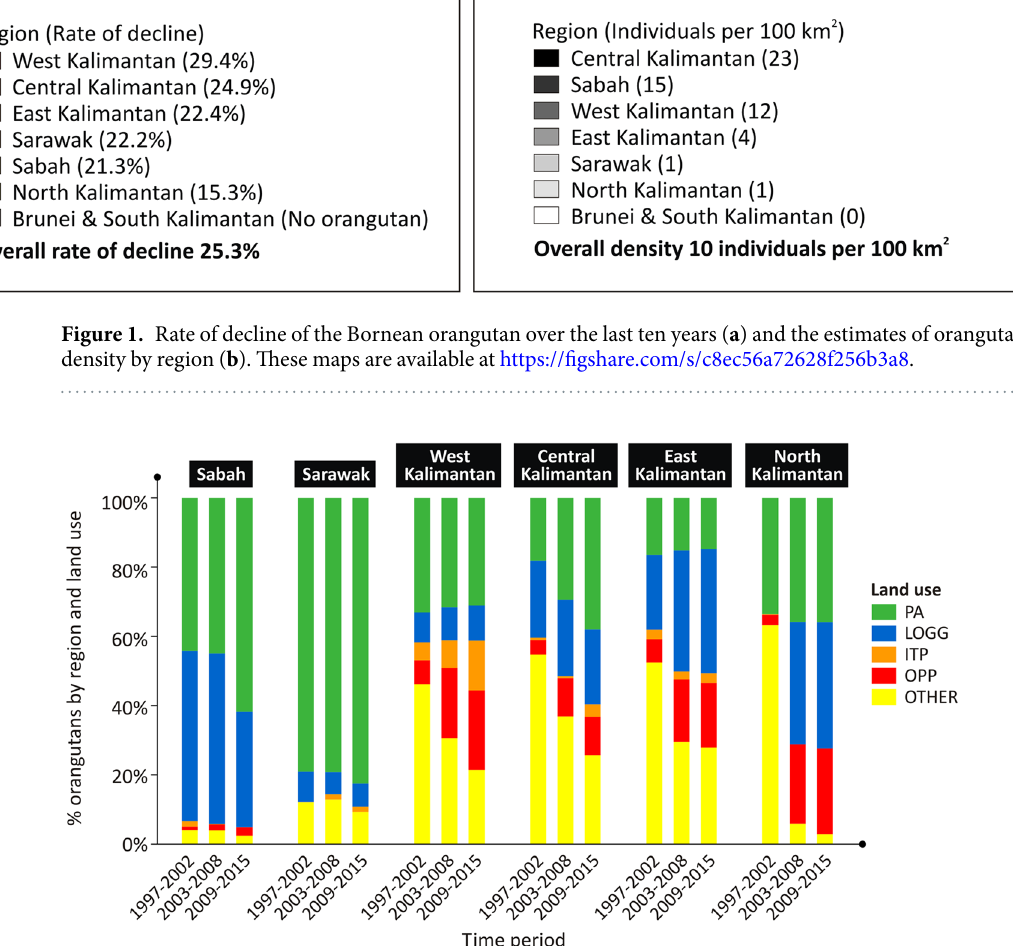
boundaries of PA and LOGG and in areas without concessions (or classified as ‘OTHER’). Across the whole of Borneo, the proportion of orangutans residing within the boundary of PA has increased through time (Fig. 2), mainly because the orangutan populations have gradually disappeared from other land uses and/or the extent of PA had increased recently 9, 10, 20 , e.g. with the establishment of the Sebangau National Park in Central Kalimantan,